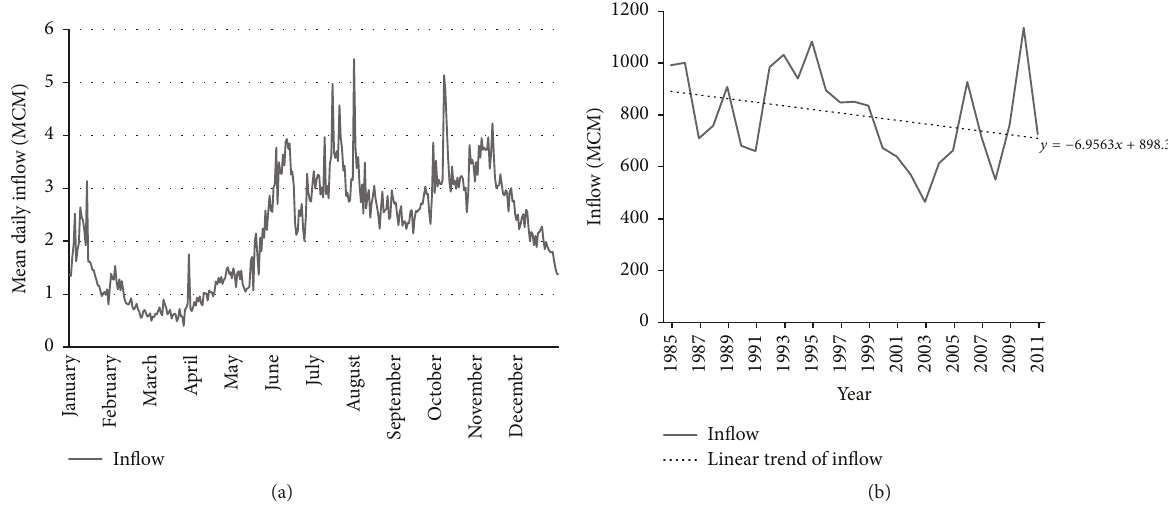
Figure 10: Daily mean inflow (MCM) (a) and annual change of the inflow (b) for Kotmale reservoir, Sri